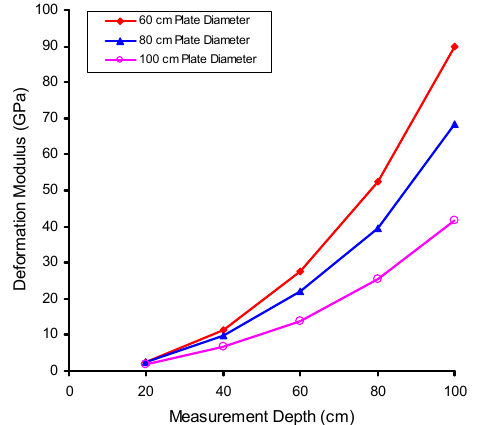
Figure 15. The effect of plate load diameter on deformation modulus variation as a function of displacement measurement depth.